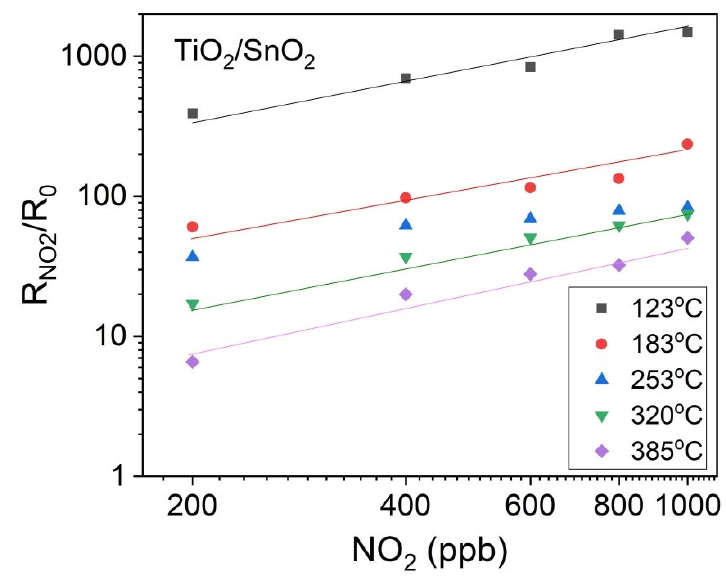
Figure 13. The SnO 2 / TiO 2 thin film response to low NO 2 concentrations at di ff erent operating temperatures. Table 2. Kinetics of the SnO 2 / TiO 2 thin film response to NO 2 of two di ff erent concentrations; t resp —response time, t rec —recovery time.